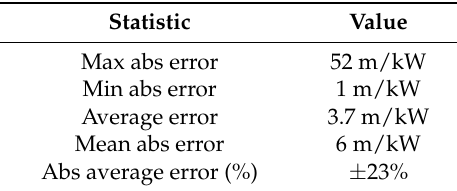
Figure 5. Map of required BHE length to satisfy the imposed energy demand of the referential refurbished MINERGIE ® building considered in the simulations. Table 8. Comparison statistics between measured and computed borehole heat exchanger (BHE)